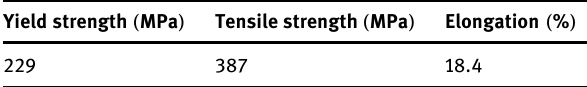
Table 2: Mechanical properties of the test